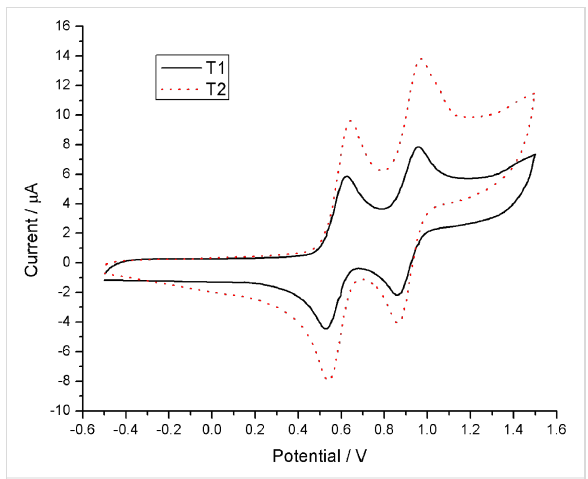
Figure 6: Cyclic voltammograms of T 1 and T 2 in DCM. Conditions: 0.1 M tetrabutylammonium hexafluorophosphate, 100 mV s − 1 , Ag/AgCl as the reference electrode, Pt wire as the counter electrode, and glassy carbon as the working electrode; measured under argon at 20 °C. Concentration: 1 mM for T 1 and 1 mM for T 2 .